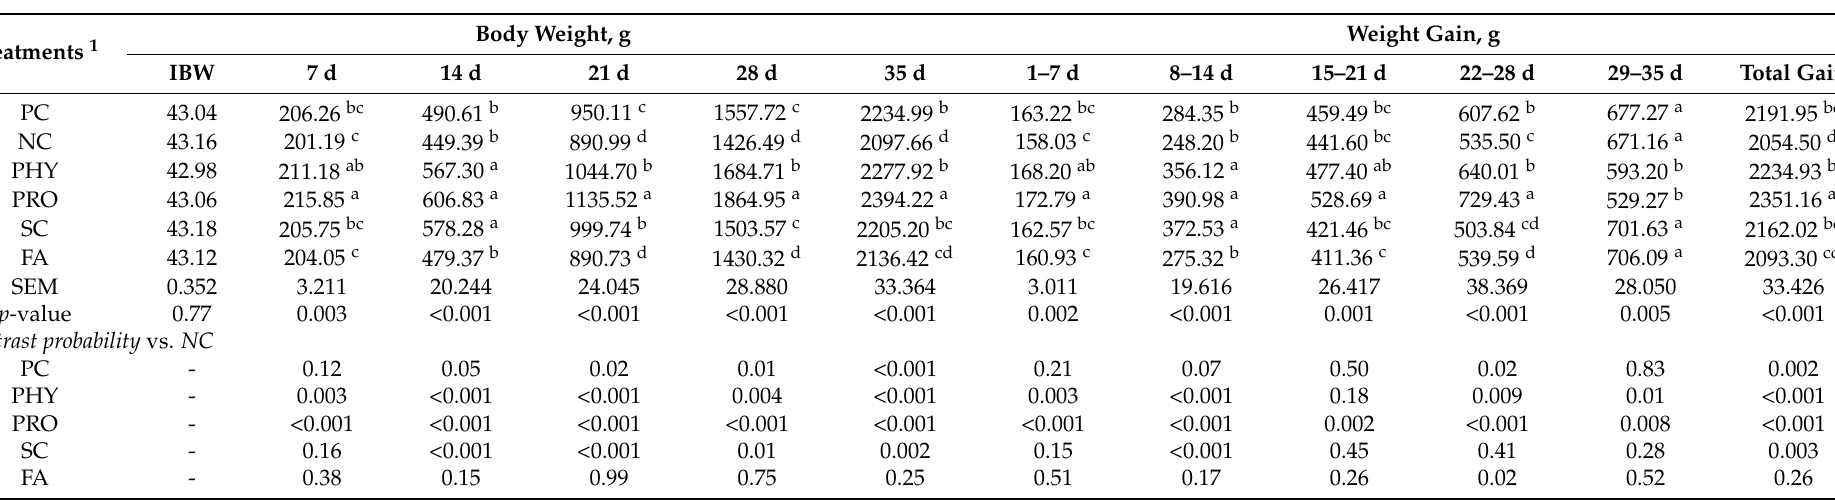
Table 2. Body weight and gain of broiler chickens fed a reduced nPP diet supplemented with phytase, probiotic, Saccharomyces cerevisiae , and fumaric acid during the